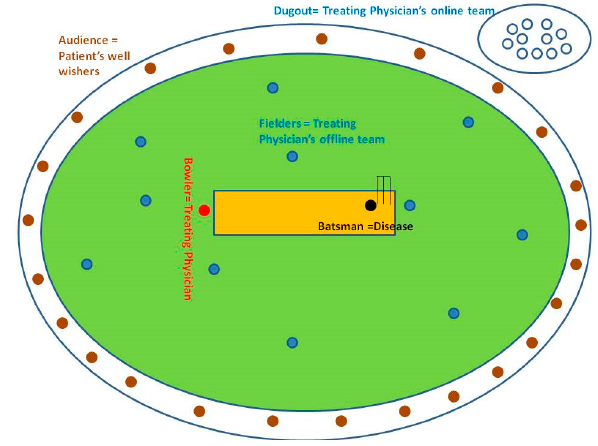
Figure 2. Illustrates the analogy of healthcare ecosystem functioning in the form of a cricket match.